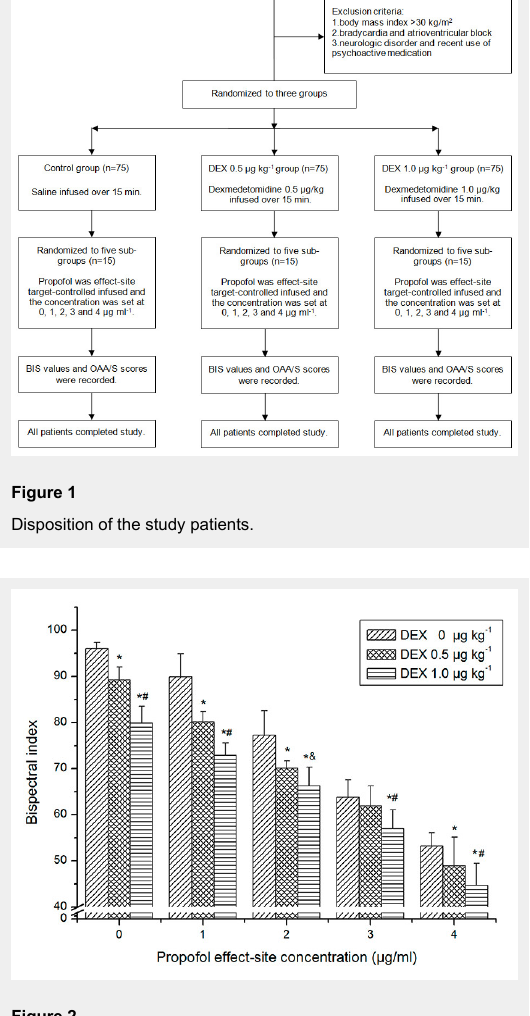
The effects of dexmedetomedine on bispectral index at every propofol effect-site concentration. Bars represent mean ± SD. * Significant differences compared with control group at the same propofol effect-site concentration (p <0.01). # Significant differences between dexmedetomidine (DEX) 0.5 and 1.0 μg kg –1 (p <0.01).